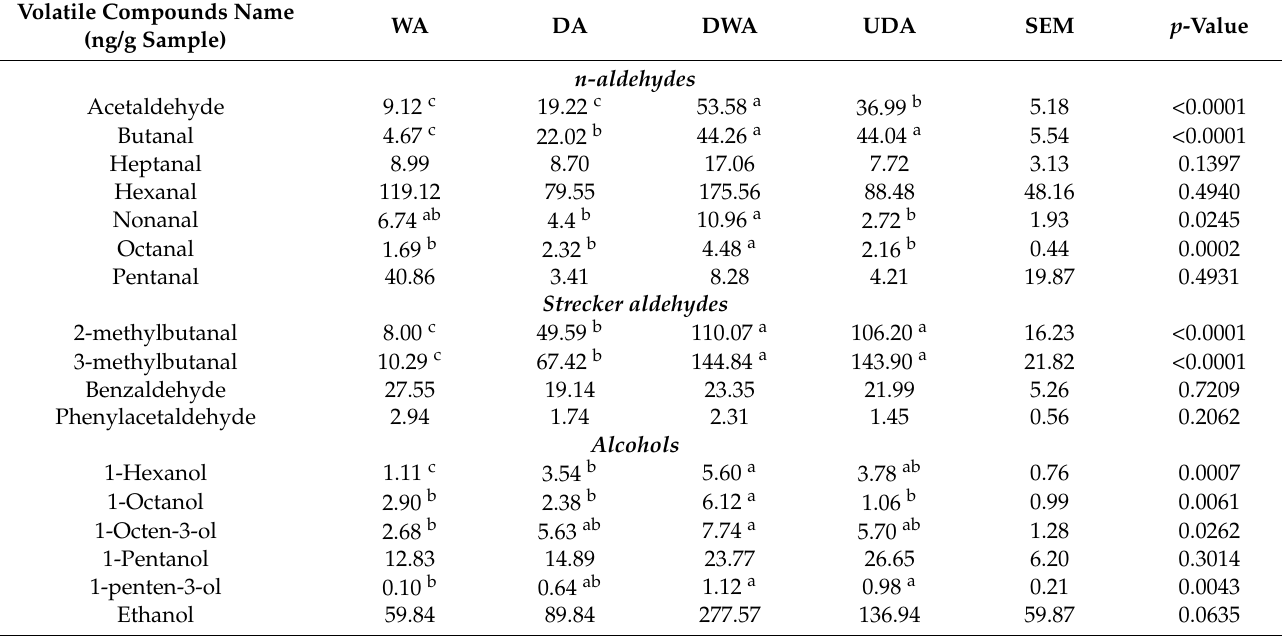
Table 3. Effect of different aging methods on the volatile compound profiles of cull cow beef loins ( M. longissimus lumborum ) after 28 days of